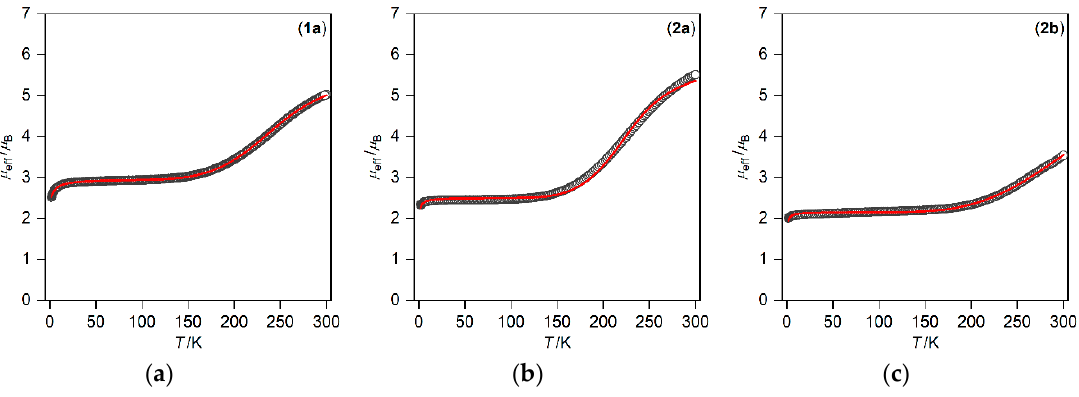
Table 1. Crystal data and details of structure determination.